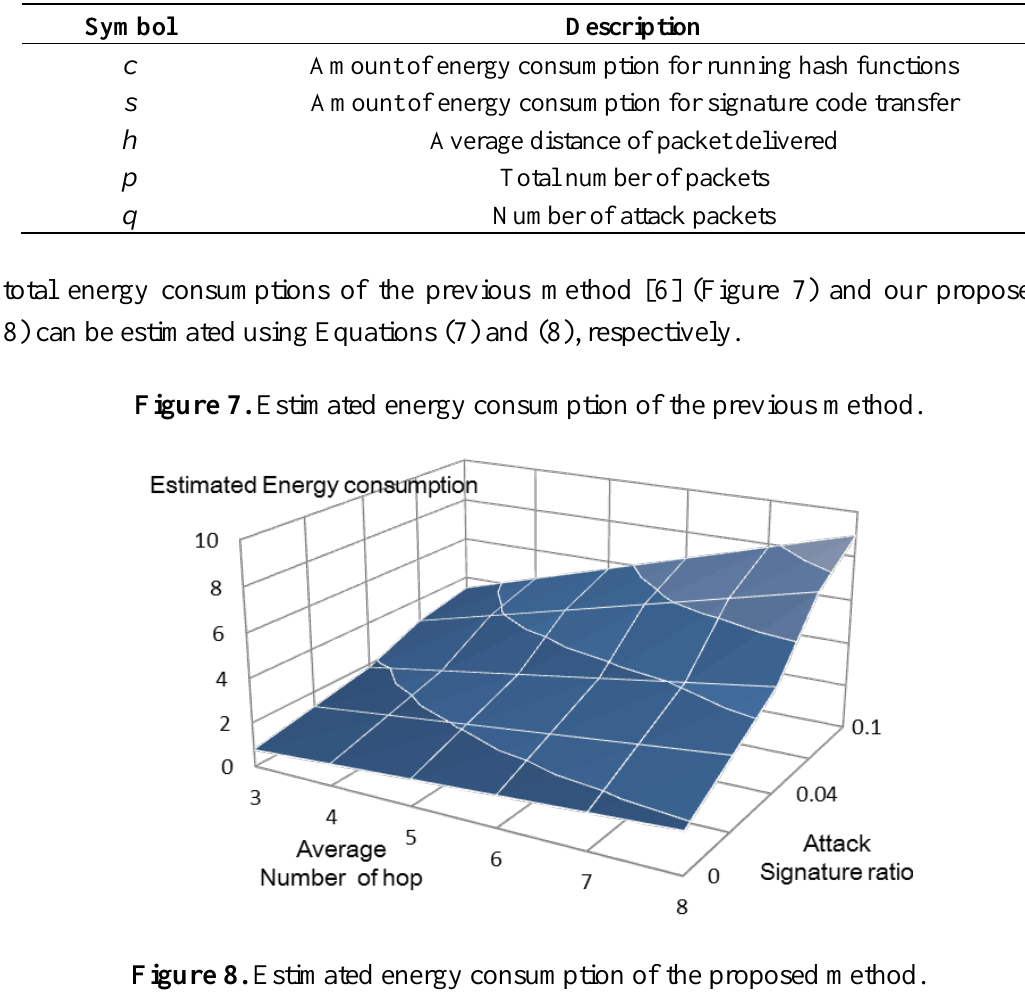
Figure 8. Estimated energy consumption of the proposed